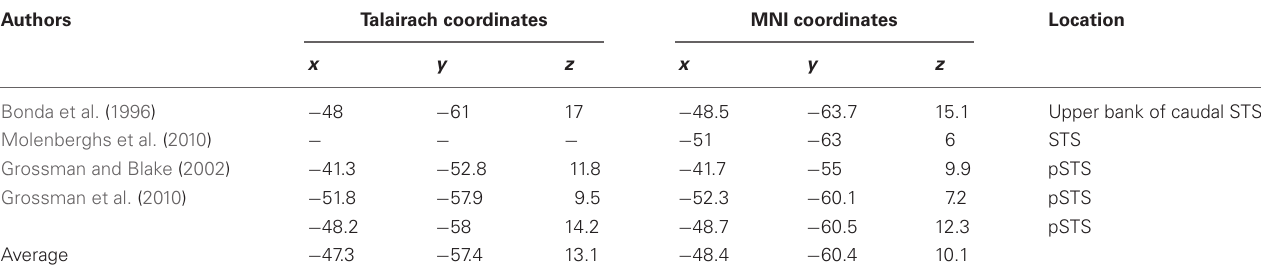
Table 3 | Peak coordinates in left